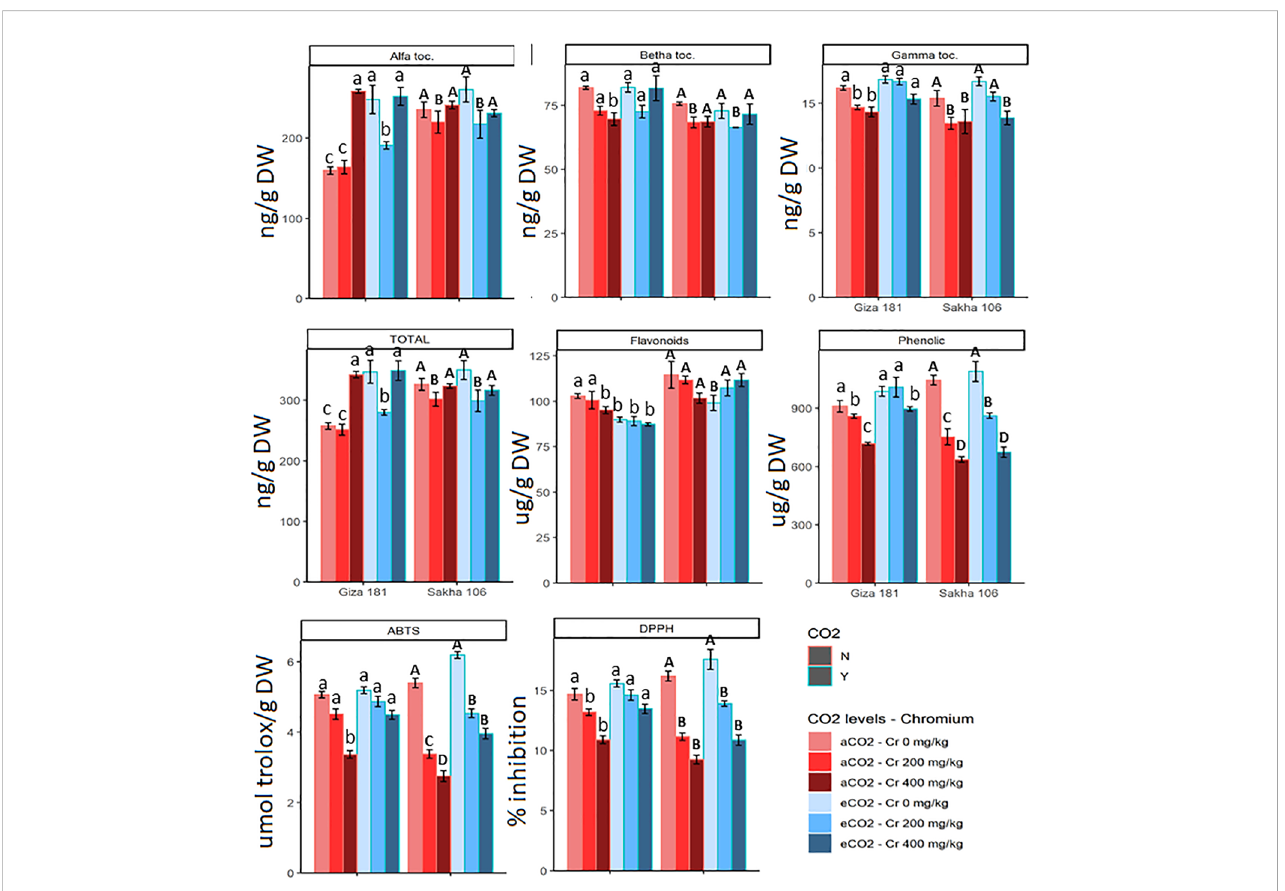
FIGURE 4 Effect of Chromium (Cr) exposure on the levels of molecular antioxidants and total antioxidant capacities of rice grains produced under either aCO2 (410 ppm) or eCO2 (620 ppm). Values are presented as means± standard error of 4 independent replicates. Different letters within the same cultivar represent signi fi cant differences between means (Tukey's Test; P <